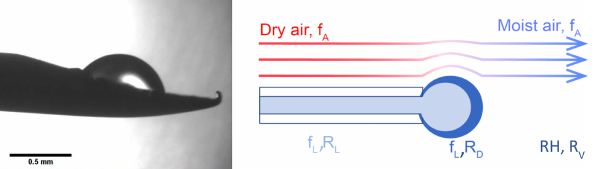
Figure 1. Evaporation of a droplet in the humidity generator cham- ber: the left panel shows a picture from the prototype from Lands- berg (2014), and the right panel displays schematics of the water molecules being transferred to the air flow (Casado,